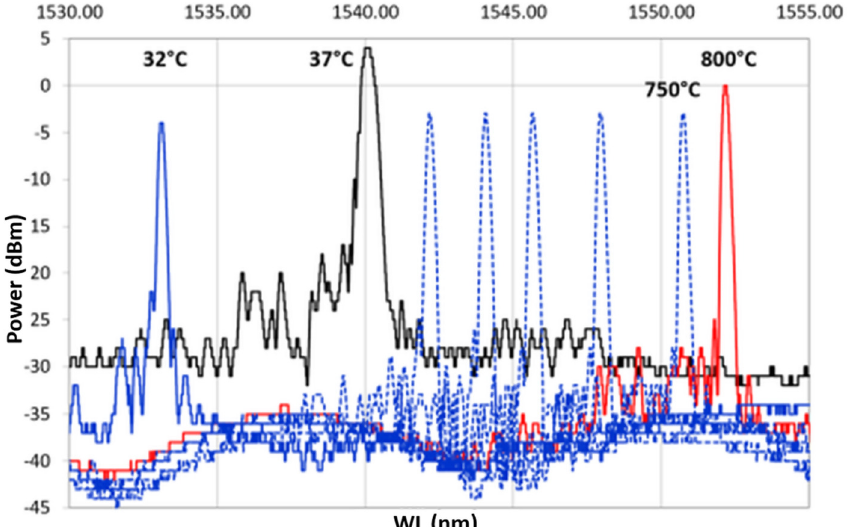
Figure 10. Cooling ramp of the thermal cycle from 800 ◦ C, represented with a continuous red line, to 32 ◦ C, represented with a continuous blue